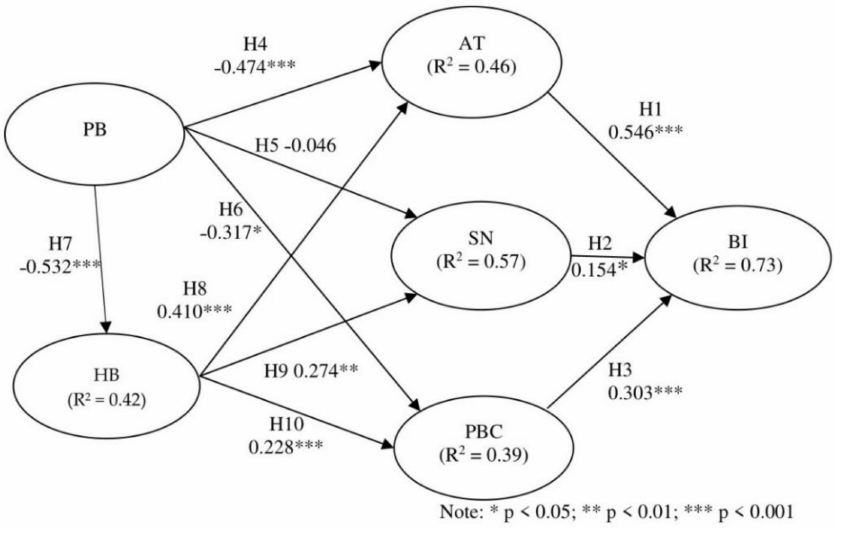
Figure 3. Final model for prediction the willingness to cycle in a university